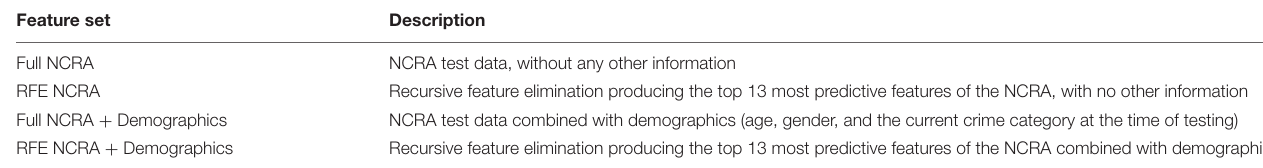
TABLE 6 | Feature sets defined, as used in machine learning modeling analysis. Feature